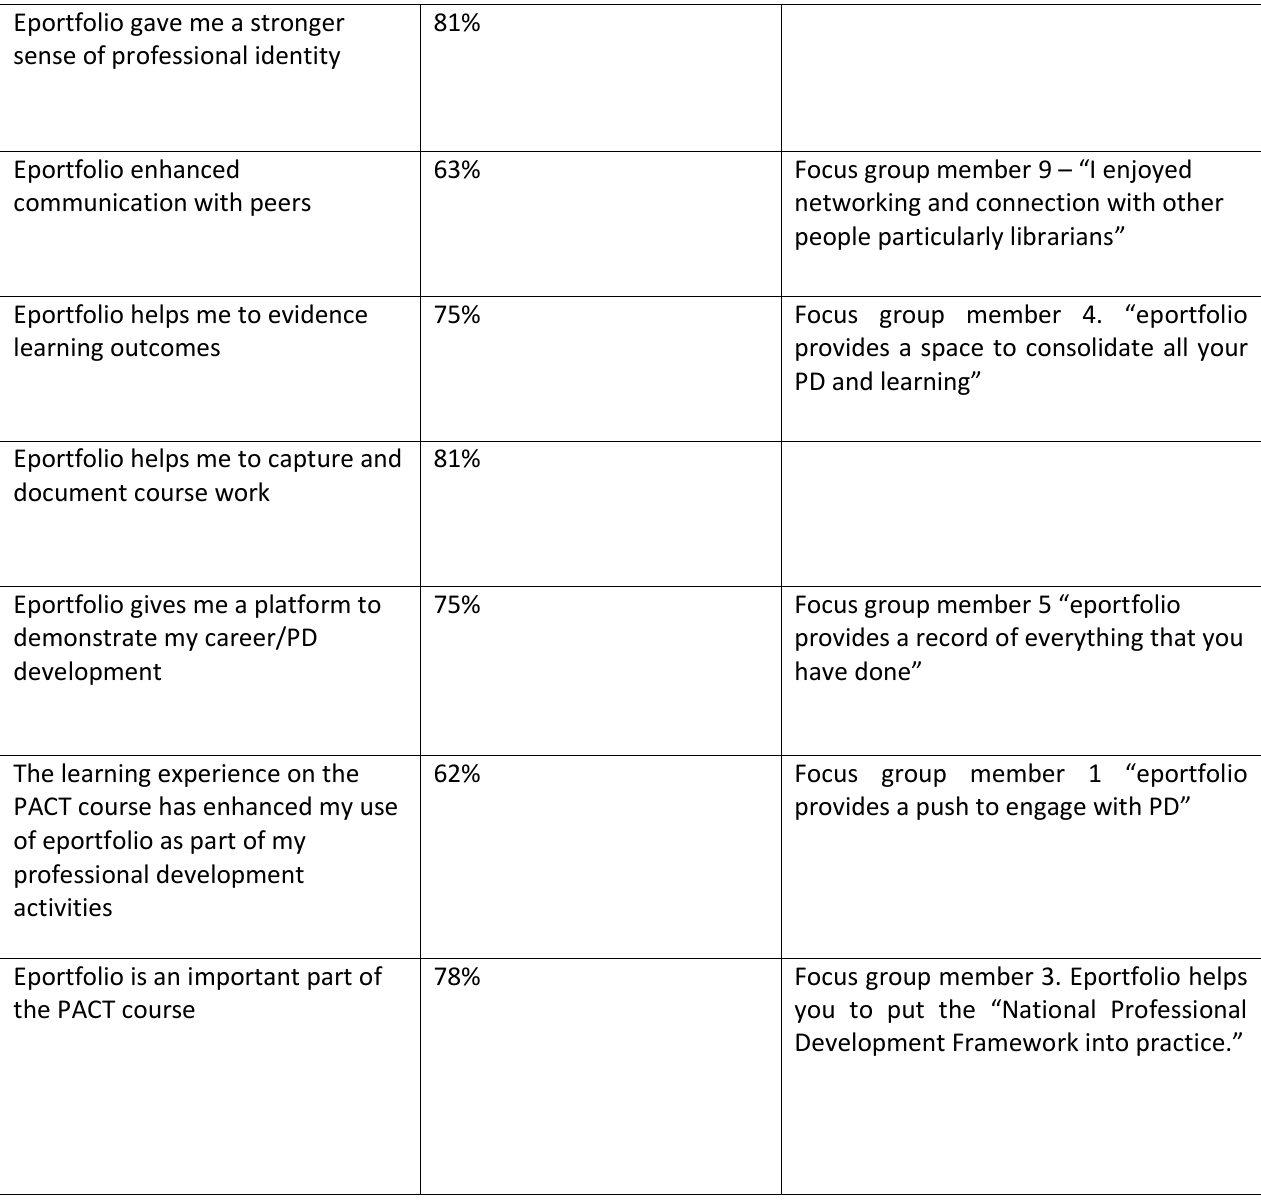
Table 2: Additional Skills from the eportfolio element of the PACT